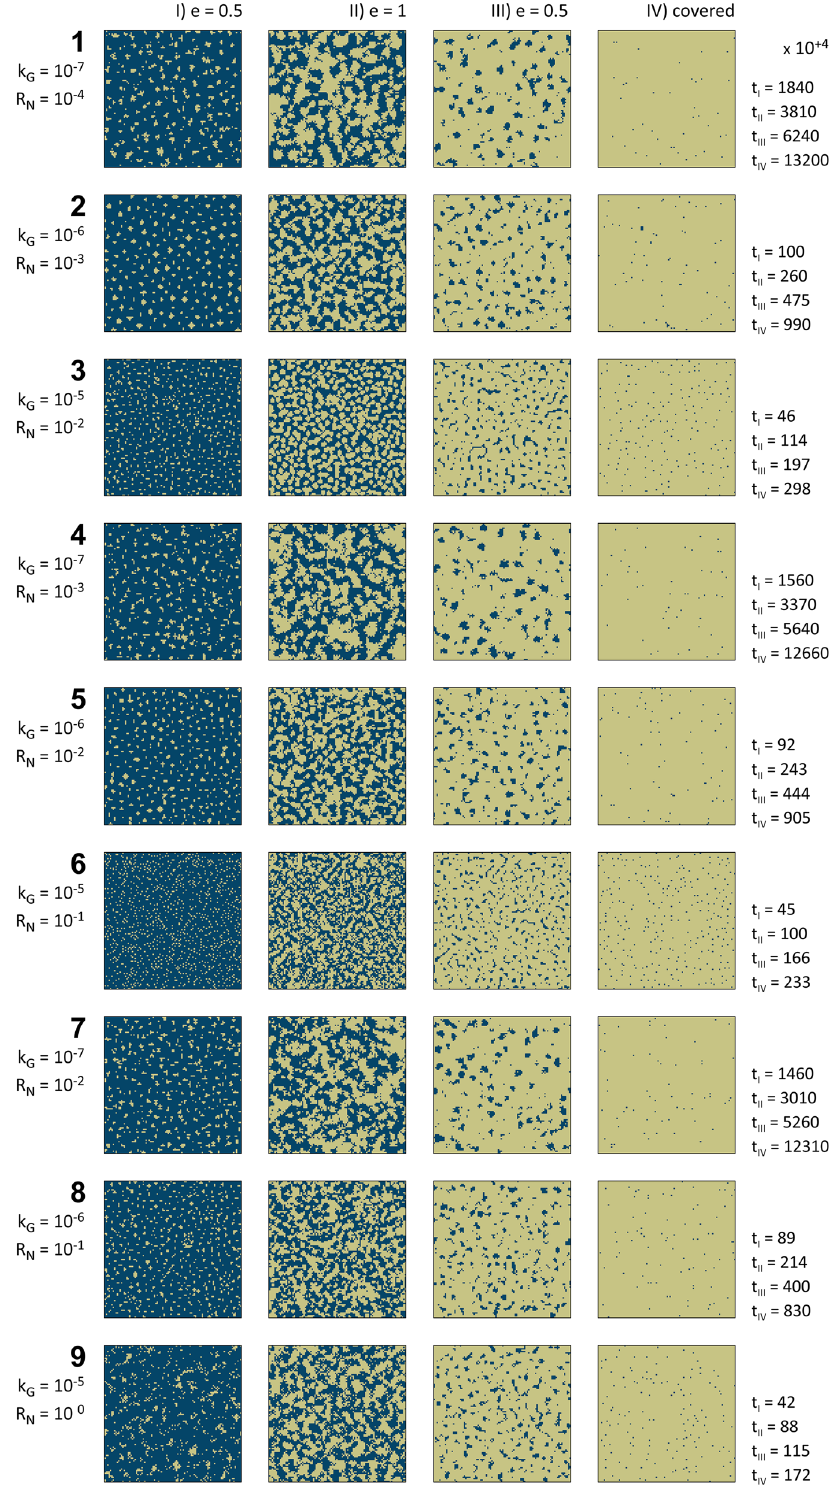
Figure 3. Precipitation maps of nine Lattice Boltzmann Method (LBM) reactive transport simulation scenarios implementing probabilistic nucleation model are given over the entire evolution time of the system. Each map represents a 400 × 400 µm system with a grid resolution of 4 µm. For each scenario, simulation number, reaction rate constant (k G ), nucleation rate (R N ), entropy level (e) together with the corresponding simulation time-steps (× 10 4 ) are shown. The simulation scenarios represent reaction rate constant (k G ) over three orders of magnitude (10 –7 to 10 –5 ), and nucleation rate (R N ) over 5 five orders of magnitude (10 –4 to 1 0